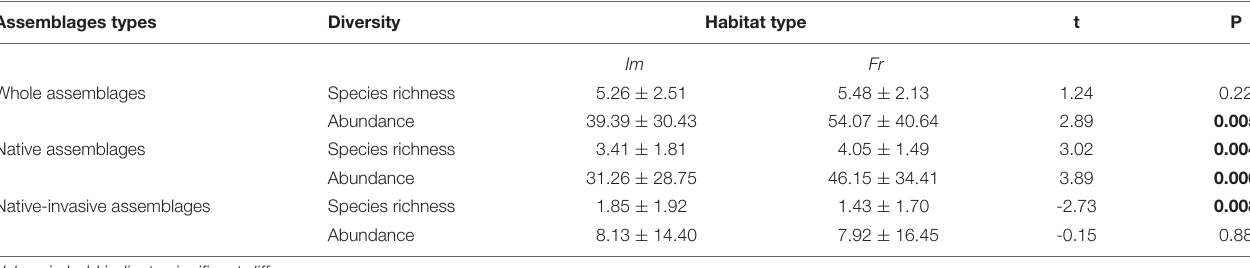
TABLE 2 | Spatial variations in species richness and fish abundance (mean ± standard deviation) between the impoundments ( Im ) and free-flowing segments ( Fr ) for whole, native, and native-invasive assemblages based on the paired samples t -test.